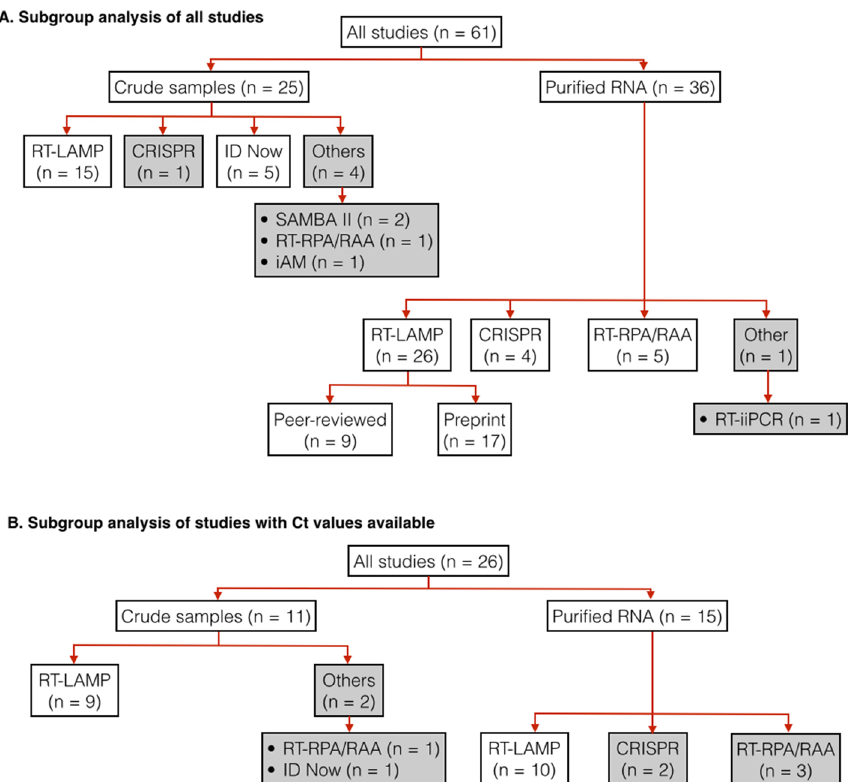
Figure 4. Hierarchical subgrouping of studies for meta-analysis. (A) subgrouping of all qualified studies. (B) subgrouping of only qualified studies that provide Ct values of positive samples. “n” indicates the number of studies in a subgroup. Pooled diagnosis results from subgroups in white boxes were used for calculating pooled sensitivity, specificity and DOR. Subgroups in grey boxes were not used for sensitivity, specificity, nor DOR calculation.